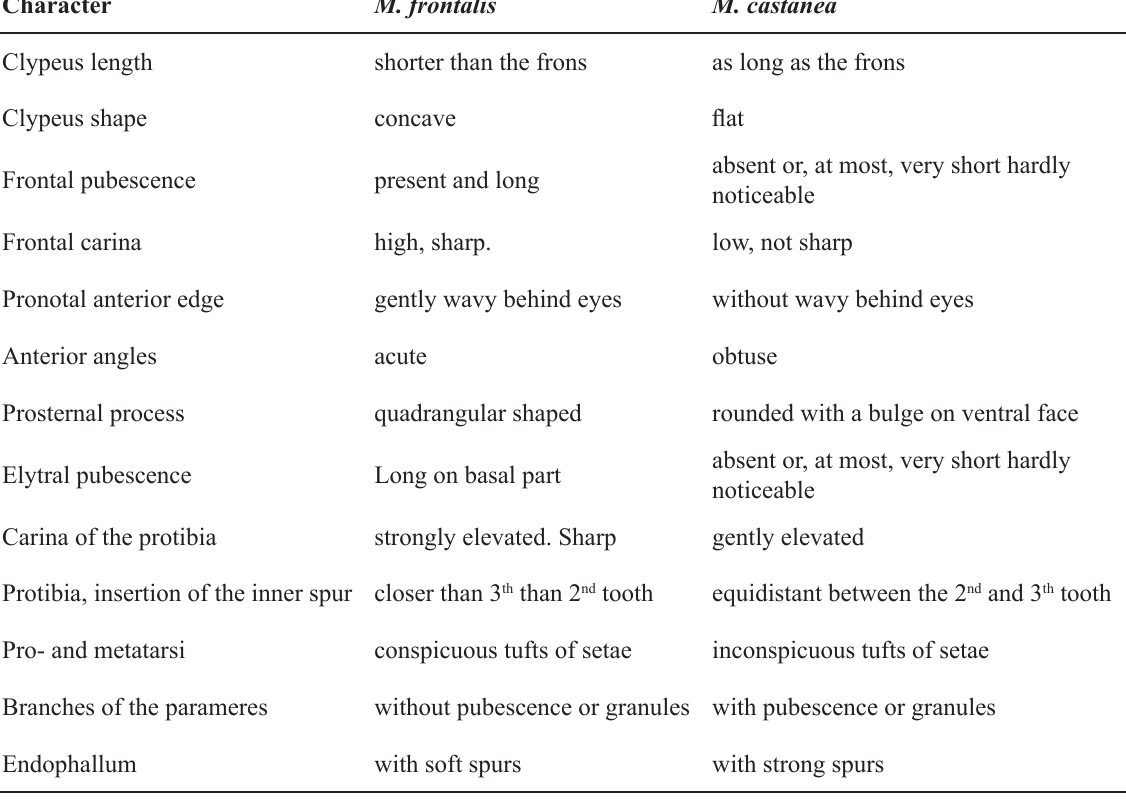
Table 2. Differences between holotype of M. frontalis (Fairmaire, 1886) and lectotype and paralectotype of M. castanea (Waterhouse, 1875)